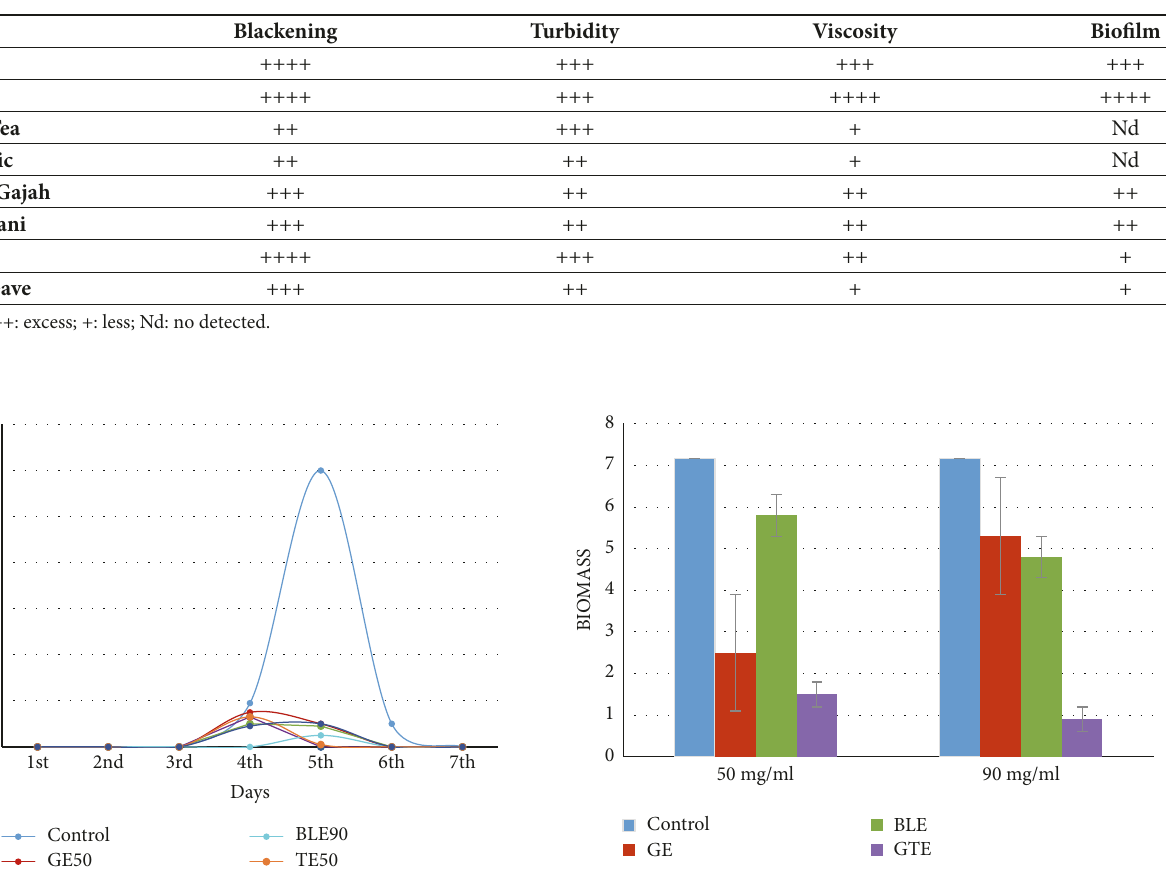
Table 1: Visual observation of the culture characteristic after treatment with biocides.